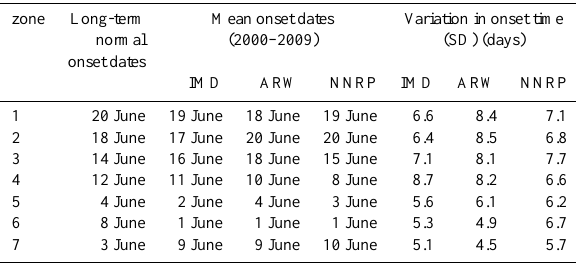
Table 2. Statistics of long-term normal onset dates, and mean, ear- liest and latest onset dates from observations and the simulation for the period